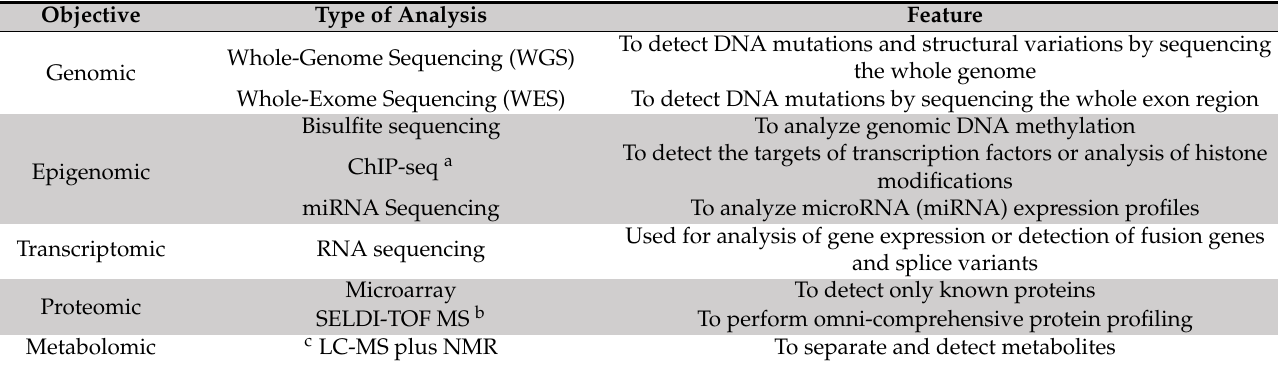
Table 2. Some High-throughput technologies and